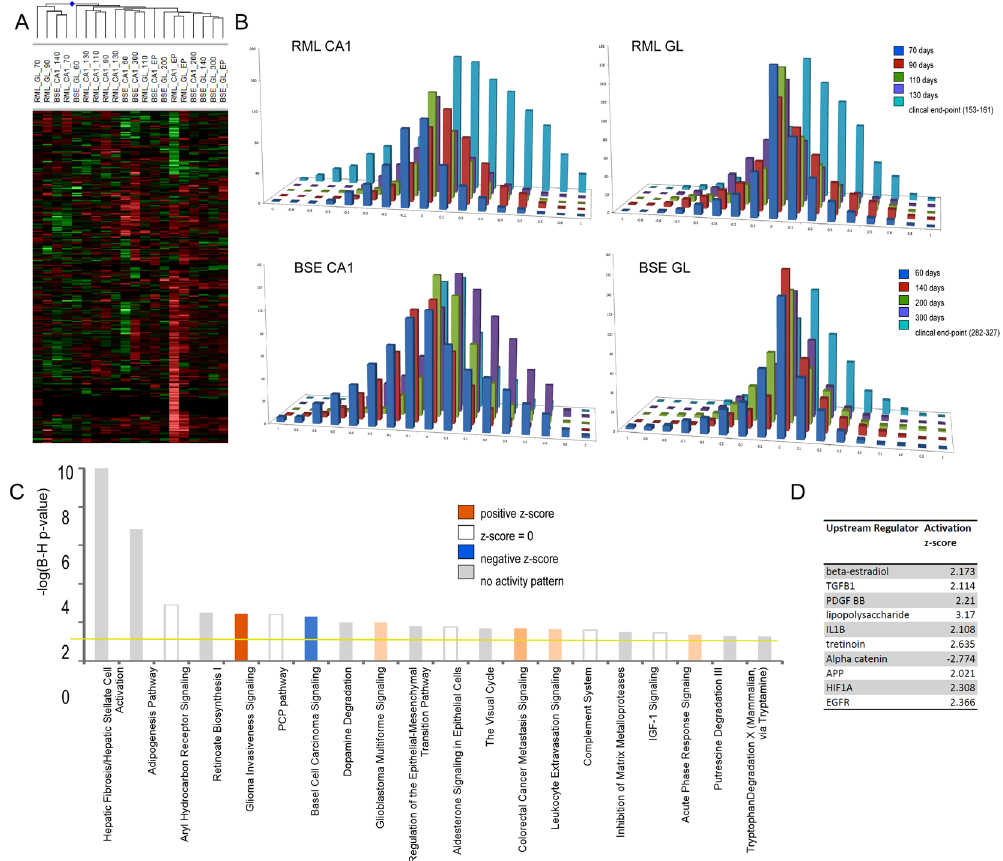
Figure 3. Dynamics and Gene Ontology analysis of genes that are enriched in astrocytes. ( A ) Heat map of astrocyte genes differentially expressed across excised hippocampal CA1 and cerebellar granule layer tissue in infections of mice with RML scrapie and BSE prions at one or more time-point after unsupervised hierarchical clustering ( n = 4–6 for each time-point). ( B ) Bar chart shows the number of astrocyte genes differentially expressed across excised hippocampal CA1 and cerebellar granule layer tissue in infections of mice with RML scrapie and BSE prions. The log ratio for each gene was binned in 0.1 increments along the x axis, and the number of genes in each bin on the y-axis. ( C ) IPA analysis shows the top 20 canonical pathways that were deregulated by astrocyte enriched genes at the clinical end-point of disease. The color of the bars indicates predicted pathway activation based on z-score (orange = activation; blue = inhibition; gray = no prediction can be made; white = z-score close to 0). The horizontal yellow line indicates the p-value threshold. Fisher’s exact test, right-tailed, was used to calculate negative log of p-value. ( D ) IPA analysis shows the top 10 predicted upstream regulators of astrocyte gene expression at the clinical end-point of disease based on